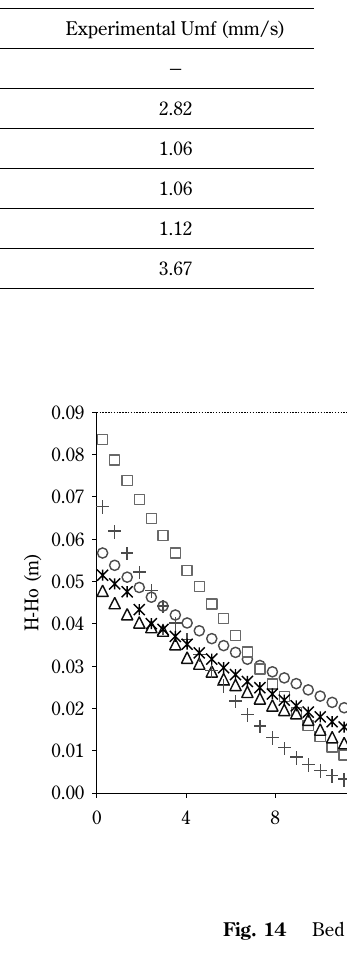
Table 5 Fluidization